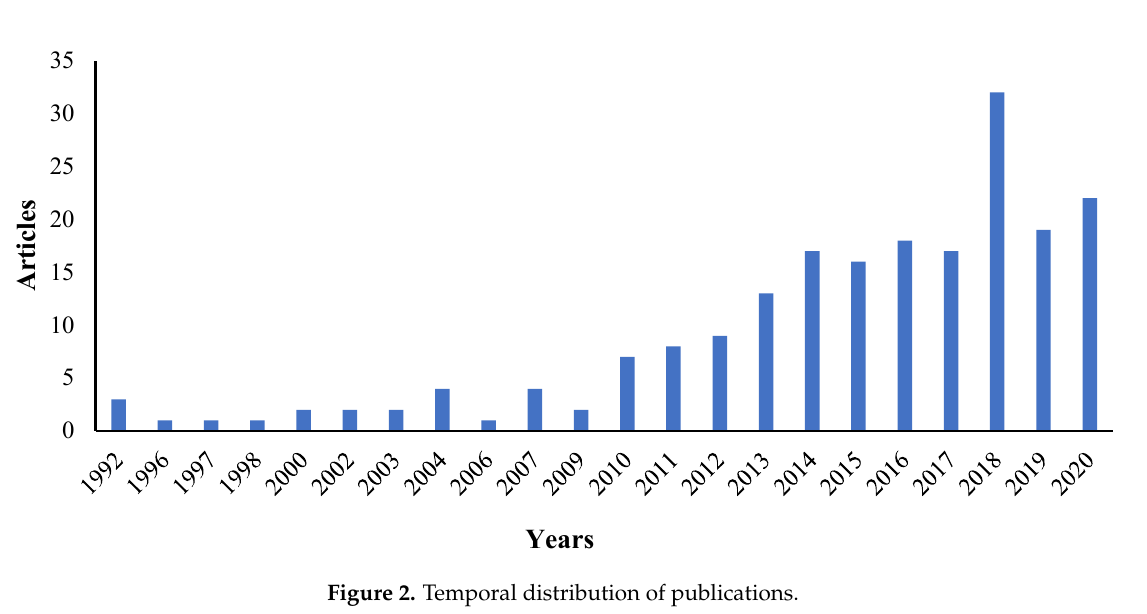
4 of 24 Figure 1. Flow diagram from literature research.